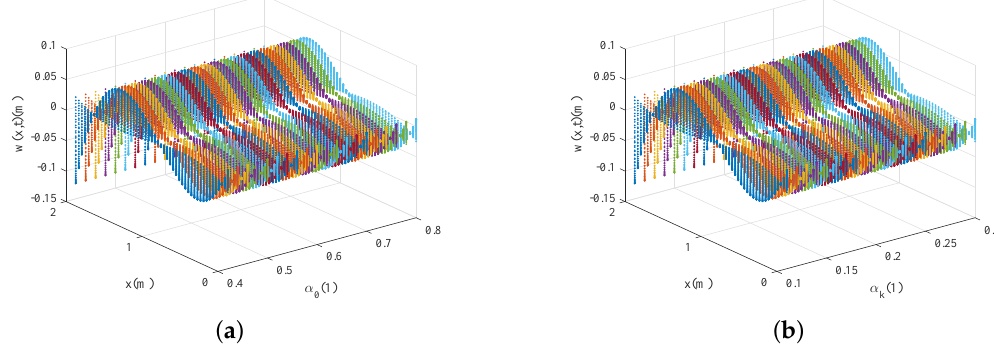
Figure 6. Oscillation response with the variable fractional order varying when n values 4 within 50 s for ( a ) basic order α 0 and ( b ) order varying rate α k